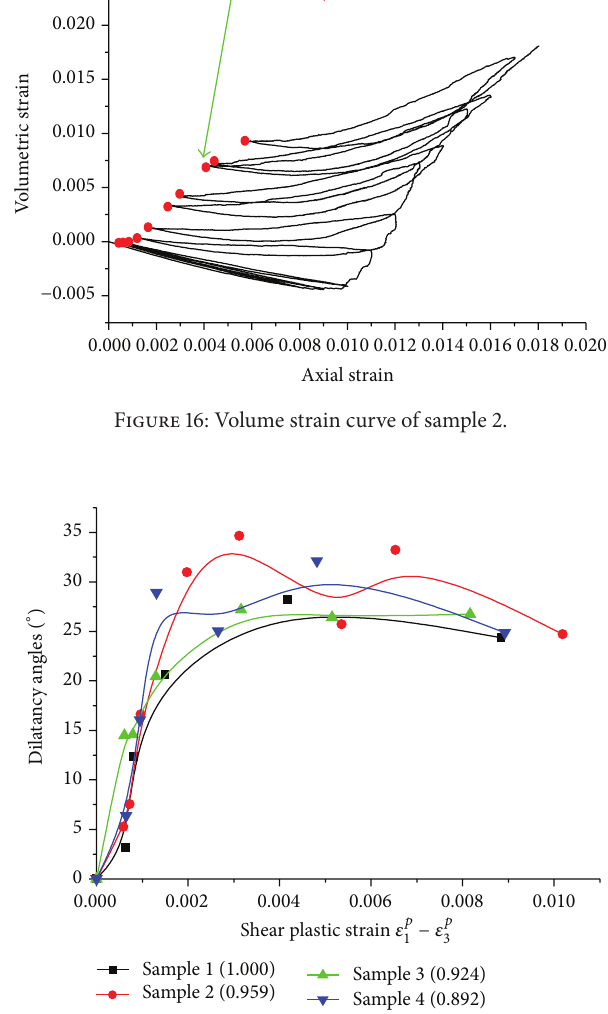
Figure 17: The relation between dilation angle and shear plastic